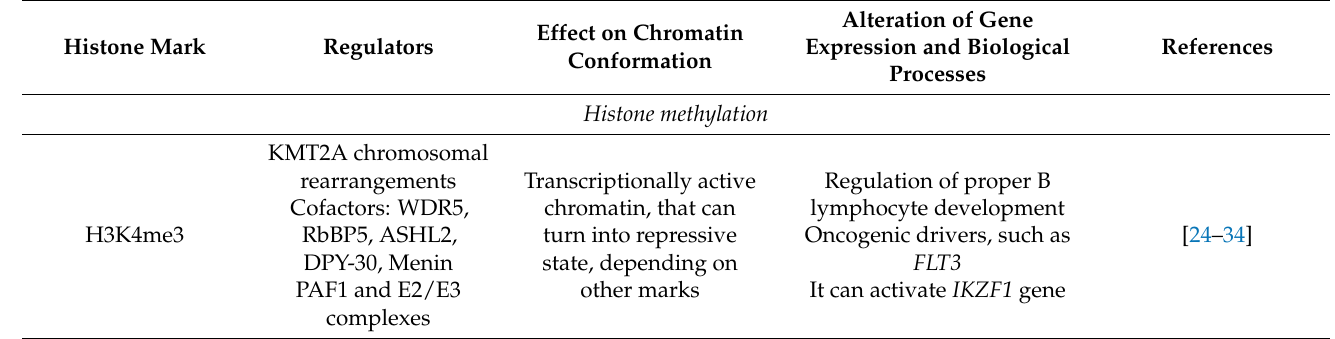
Table 1. Common epigenetic histone modifications in B-cell precursor acute lymphoblastic leukemia (BCP-ALL).